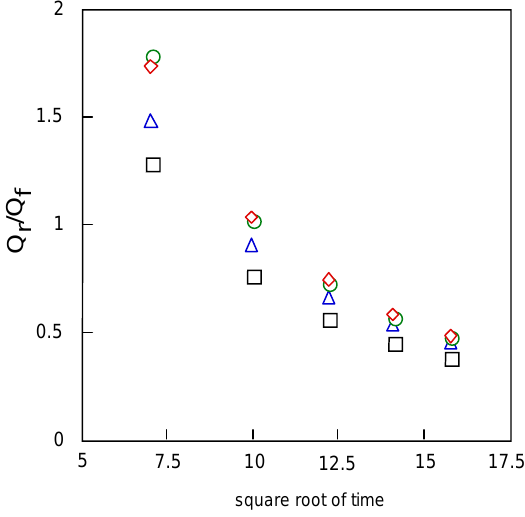
/Q with squareroot of time for covalt r f